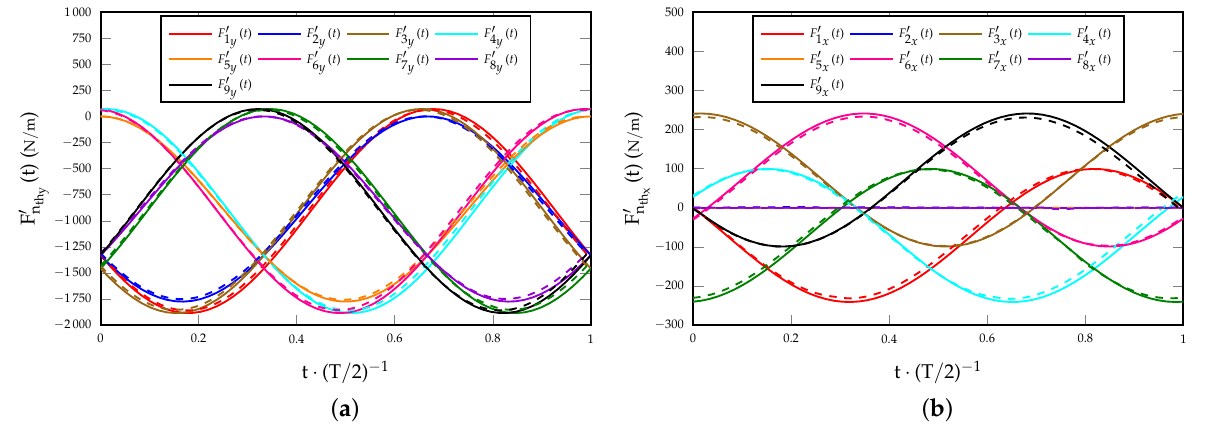
Figure 16a,b show, respectively, the normal and tangential component calculated with (13) in comparison with FEM transient simulations for each machine tooth tip (1 ≤ n th ≤ N th ), over a time interval equal to the forces period which is half the electrical period T .